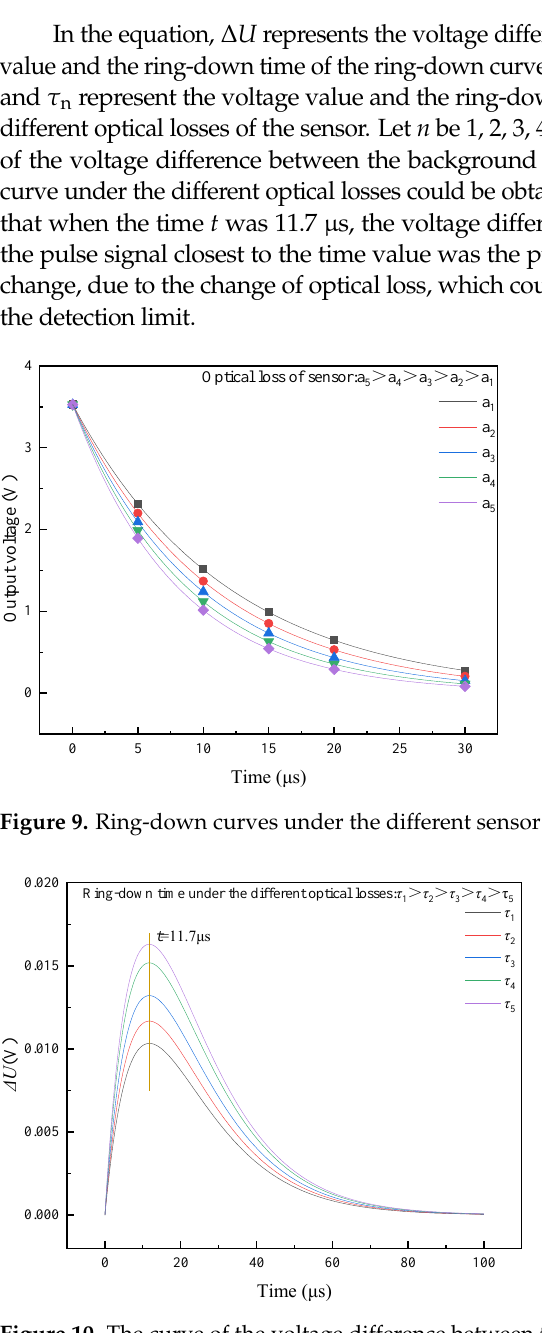
Figure 10. The curve of the voltage difference between the background gas ring-down curve and the ring-down curve under the different optical losses.